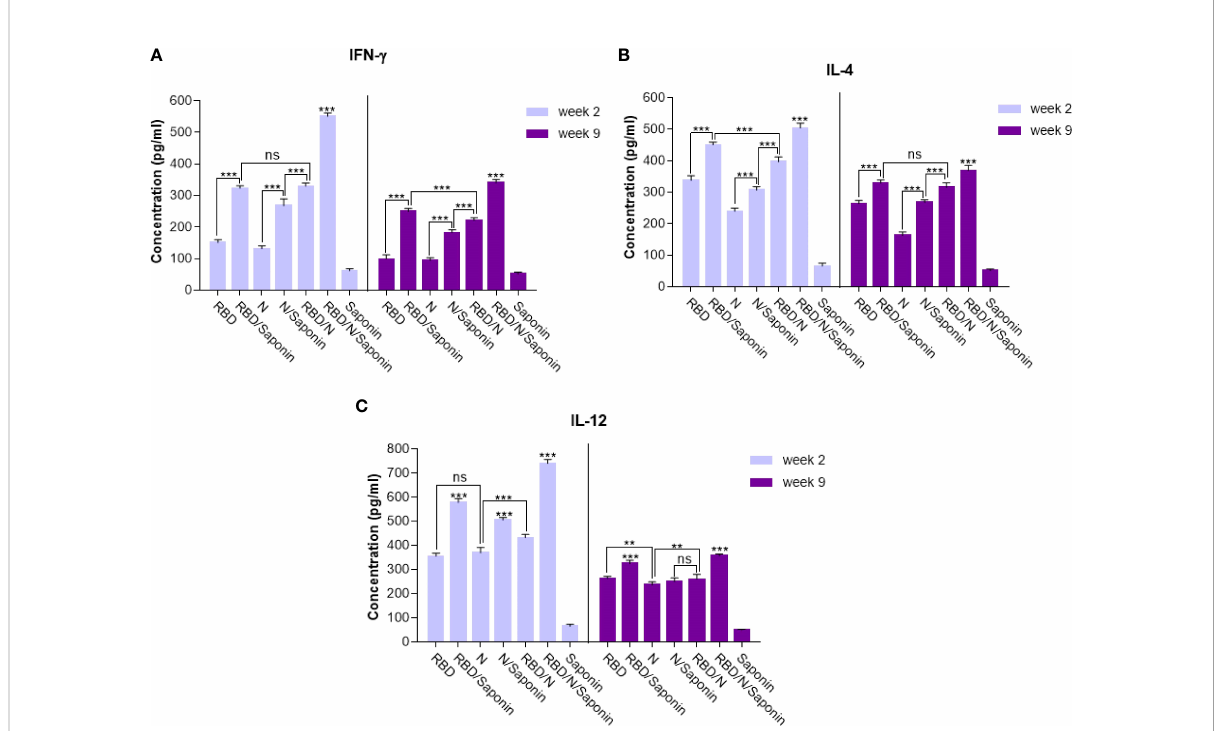
FIGURE 8 Levels of Th1/Th2 cytokine balance secreted by splenocytes in immunized mice. The supernatants of splenocytes re-stimulated with RBD/N speci fi c epitope, collected two and nine weeks after the last immunization. ELISA method was performed to determine the level of IFN- g (A) , IL- 4 (B) and IL-12 (C) in splenocyte cultures. Results are representative of three independent experiments and are expressed as the mean ± SD. The RBD/N adjuvanted with Saponin induced strong levels of IFN- g , IL-4 and IL-12 when compared to the other groups. **P < 0.01; ***P < 0.001. ns, nonstatistical